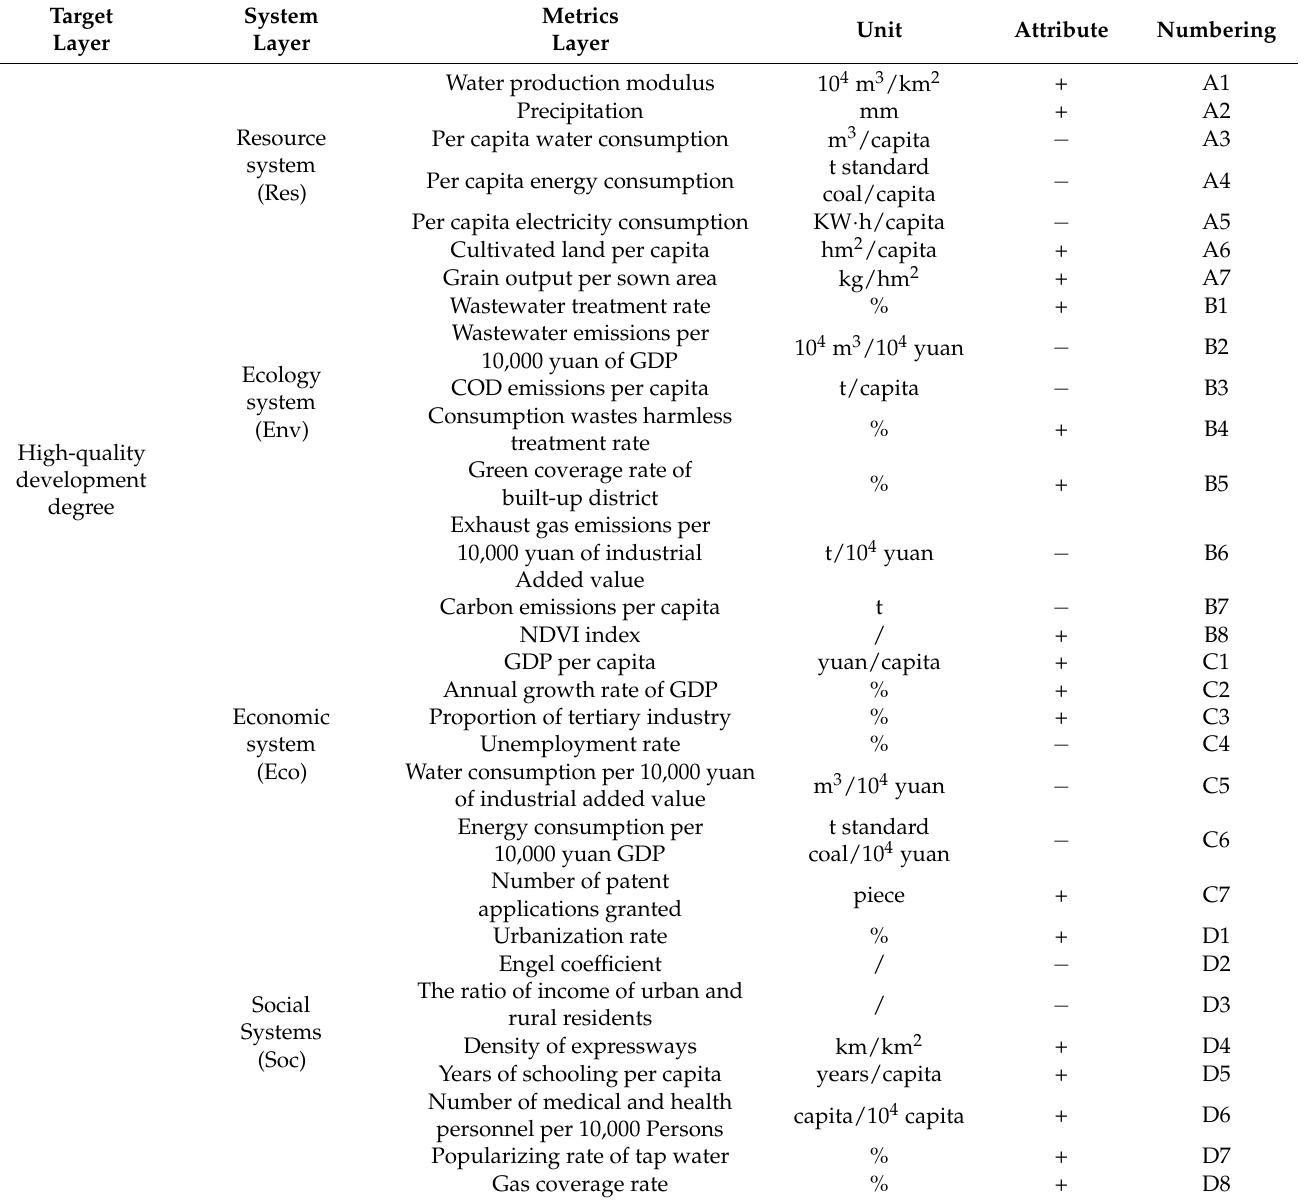
Table 1. High-quality development evaluation index